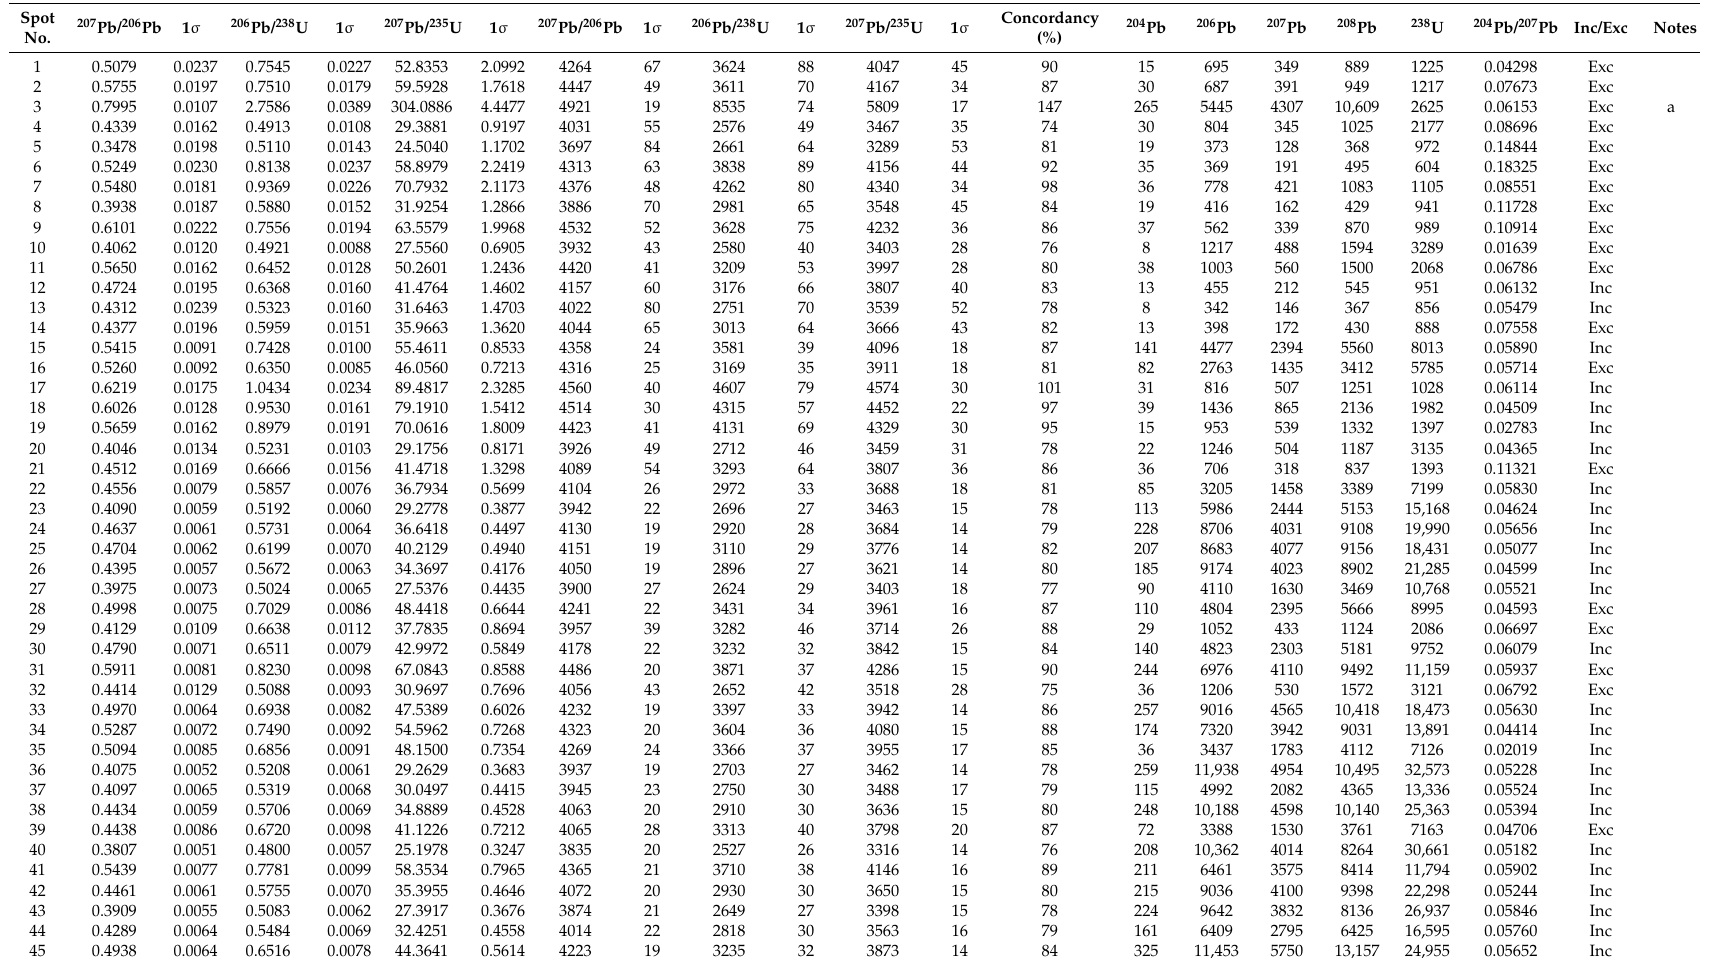
Table 5. Geochronological data for zoned hematite (sample CUR-002) using mixed-solution method. Spot